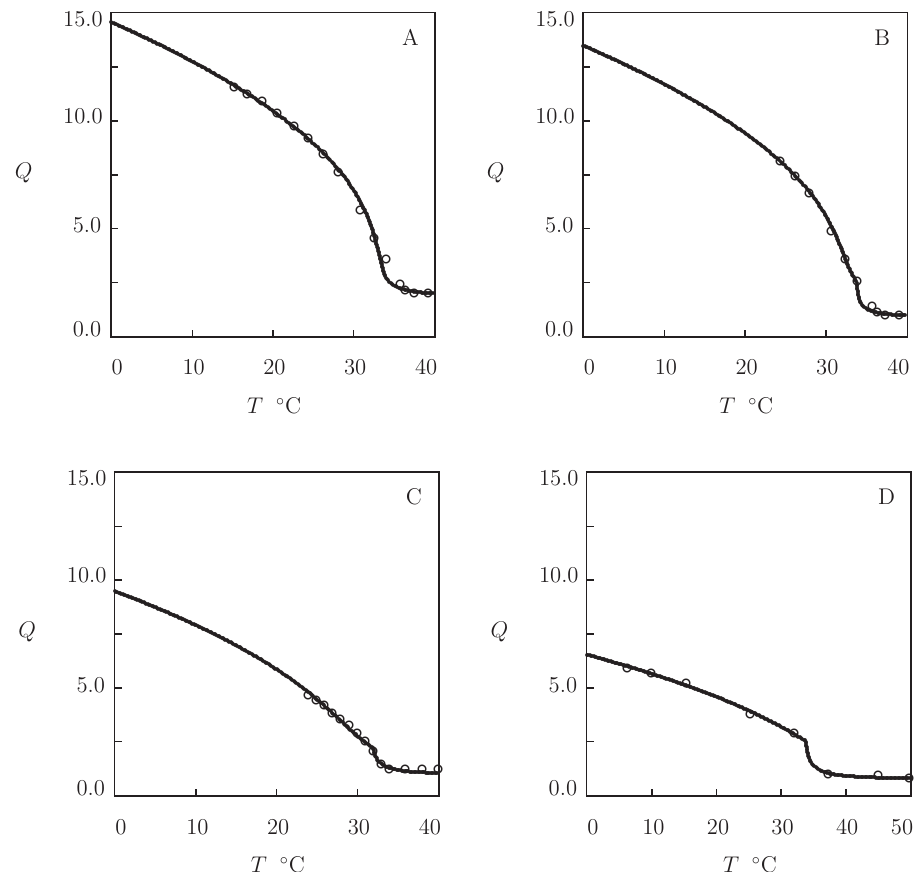
Figure 5. Degree of swelling Q versus temperature T . Circles: experimental data on PMVE gels (( A ) [32], ( B ) [60], ( C ) [61], and ( D ) [62]). Solid lines: results of